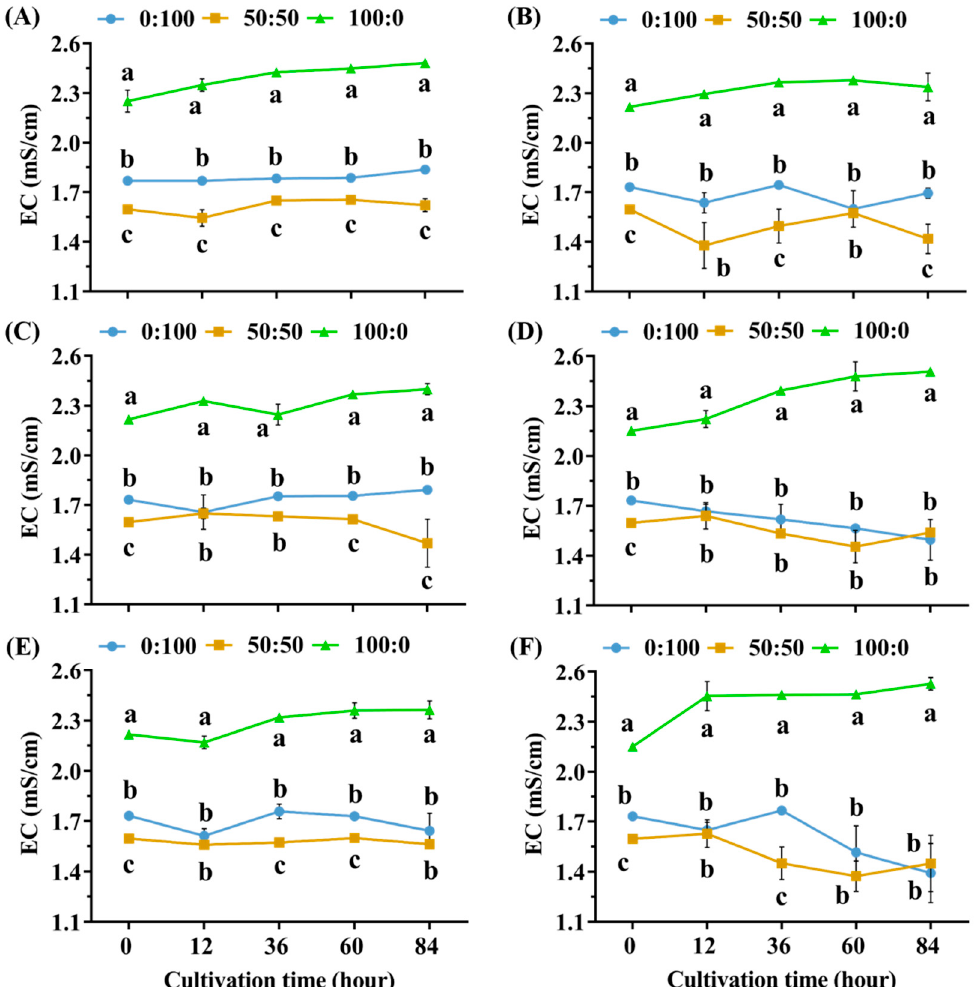
Figure 5. Kinetic variations of the EC of the three NH 4+ :NO 3 − hydroponic solutions over an 84 h period cultivation on ( A ) the control without plants; ( B ) salvia; ( C ) petunia; ( D ) ageratum; ( E ) cabbage; and ( F ) lettuce. Data are means ± SD of n = 3 biological replicates. p less than 0.05 was considered significantly different, indicated by different lower-case letters according to the one-way ANOVA (Duncan’s multiple range test).